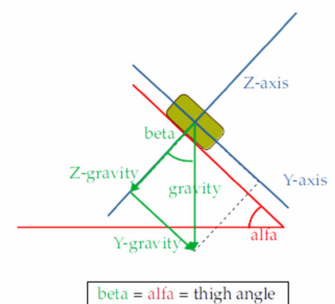
Figure 4. Computation of the thigh angle from the decomposition of gravity into orthogonal components along the axis of the reference system (blue lines) of an accelerometer on the subject’s thigh. According to the convention applied in the preceding figure the thigh angle is represented by the red angle (alfa). Gravity and its components are depicted in green. The green angle (beta) between gravity itself and its Z-component is equal to the thigh angle (alfa), because gravity is always perpendicular to the horizontal plane, and the Z-gravity component is always perpendicular to the